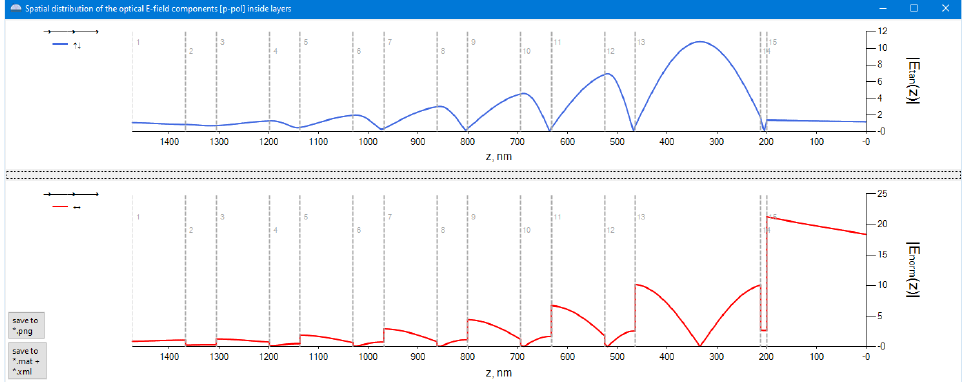
Figure 6. The spatial field distribution inside 1D